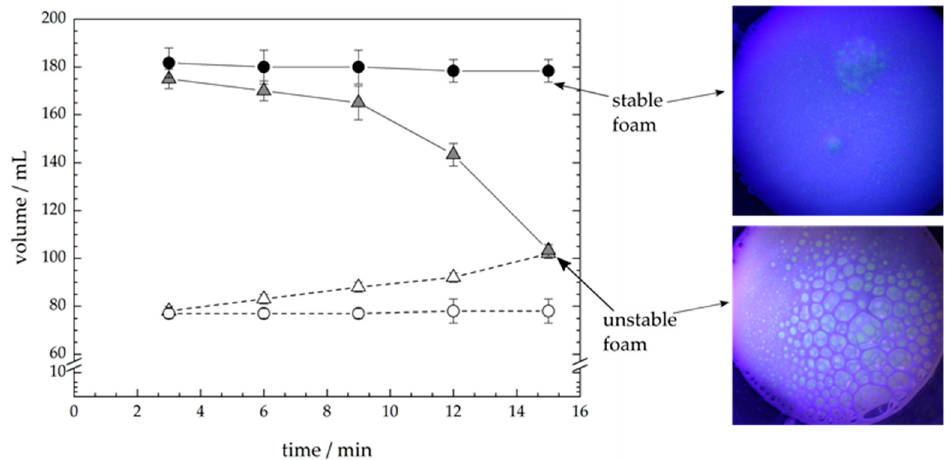
Figure 6. Total volume (solid symbols) and liquid volume (open symbols) as a function of time for UHT whole milk. Representative graphs of one stable (C4 ● , ○) and one unstable foam (C15 ▲, △) are shown. Exemplary pictures of pore sizes of one stable and one unstable foam are shown.